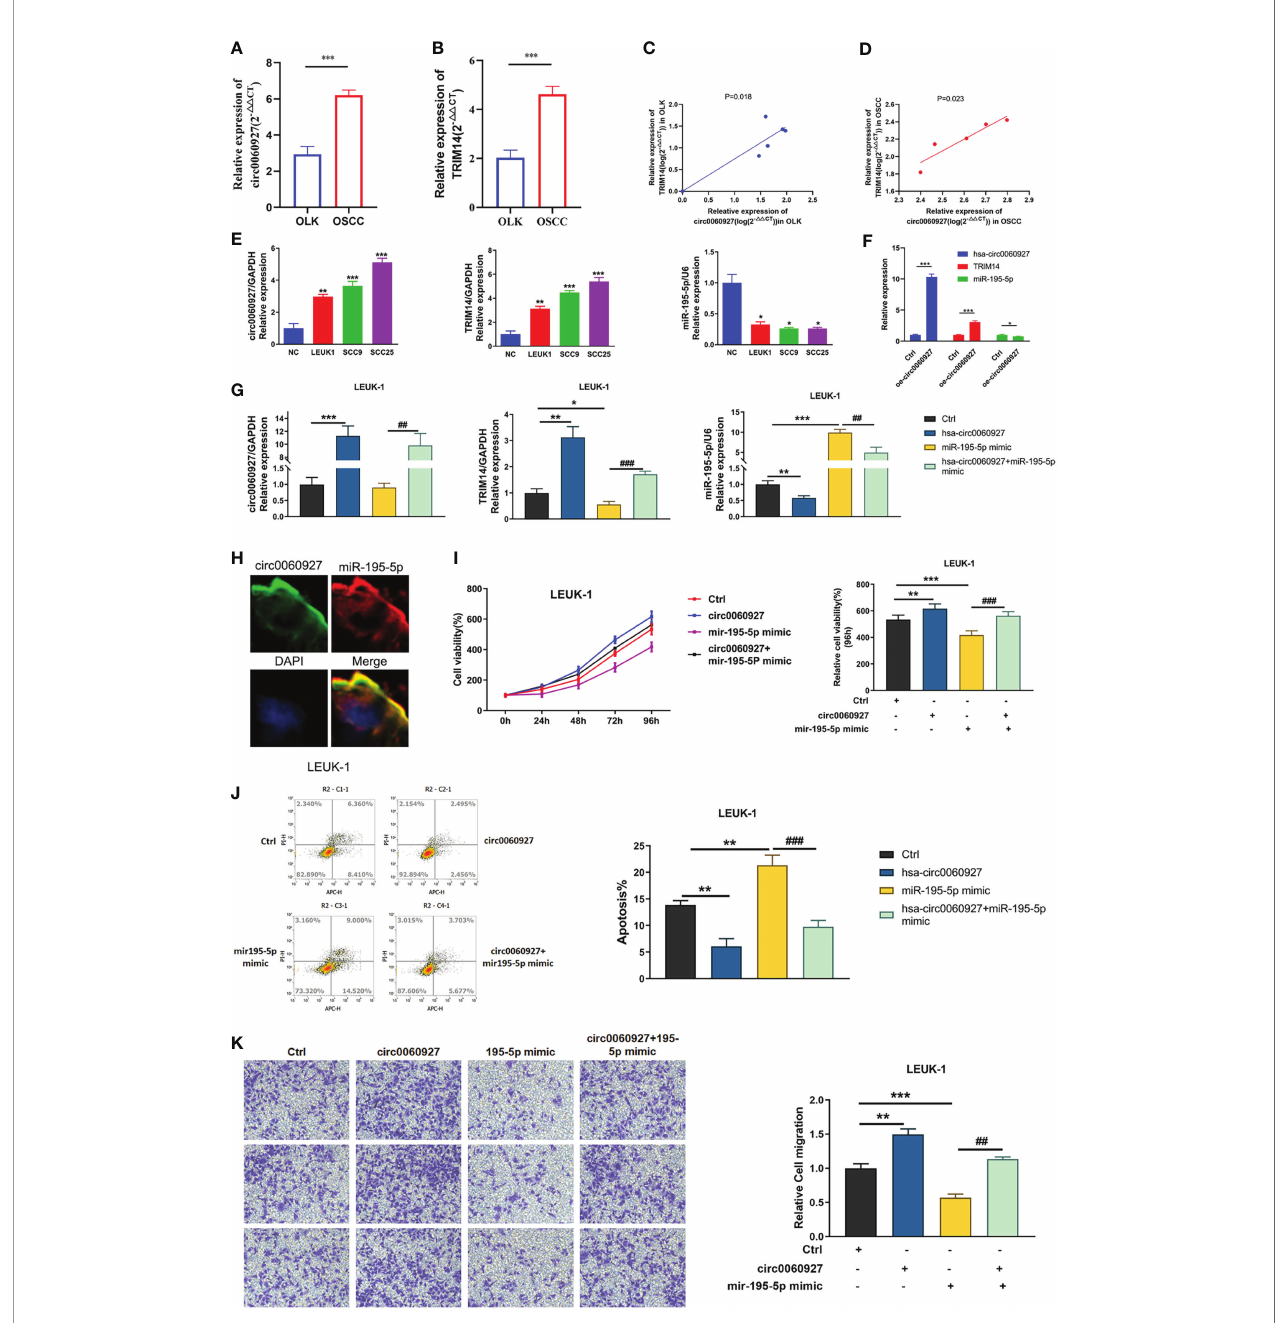
FIGURE 7 | hsa_circ_0060927 played an oncogenic role in LEUK1 cells via the miR-195-5p/TRIM14 axis. Bioinformatics prediction and Luciferase reporter assay analysis. (A) The expression of miR-195-5p and (B) TRIM14 in OLK ( n = 6) and OSCC ( n = 5). (C) Positive correlation between hsa_circ_0060927 and TRIM14 in OLK and (D) OSCC. (E) The expression of hsa_circ_0060927, TRIM14, and miR-195-5p in NOM, LEUK1, SCC9, and SCC25 cells. (F) The expression alteration of hsa_circ_0060927, TRIM14, and miR-195-5p after transfection of overexpressed- hsa_circ_0060927 (oe- circ_0060927) in LEUK1 cells. (G) The expression level of hsa_circ_0060927, miR-195-5p, and TRIM14 after overexpression of the hsa_circ_0060927 plasmid and miR-195-5p mimics. (H) The co-localization of hsa_circ_0060927 and miR-195-5p in OLK. (I) CCK-8 assay. (J) Apoptosis assay. (K) Transwell